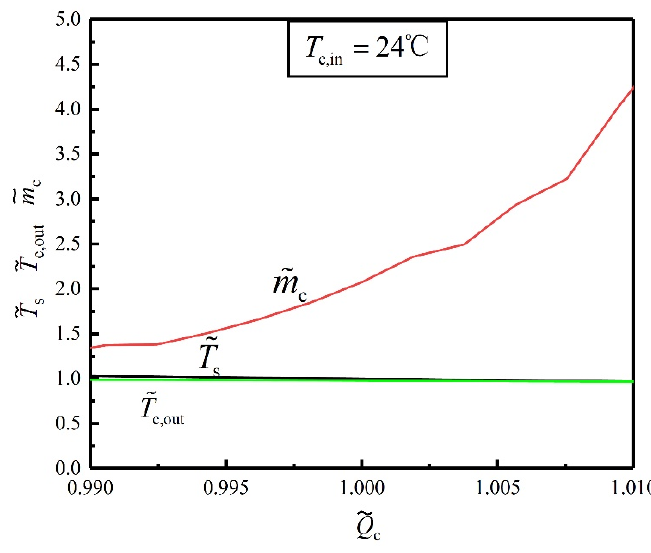
d  . 250 W  and Q  on the , , c out opt , c m c